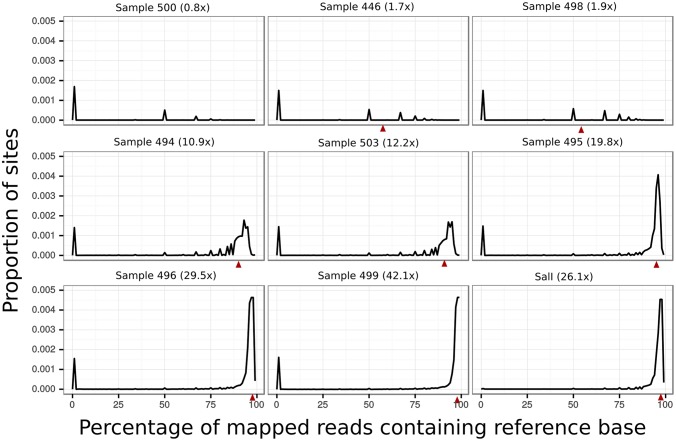
Reference base frequency spectra.The first eight panels represent the distribution of the frequency of reference bases in sequencing reads produced from our samples across all sites in the P. vivax genome. In the final panel the same distribution is graphed for reads generated from Sal-I, a known single infection. Red triangles represent the frequency expected if one non-reference containing read was mapped to a site with average sequencing coverage for that sample (given in parentheses after the sample name). The majority of sites from all samples contain only non-reference bases; these sites were removed to allow clearer visualization of these distributions.